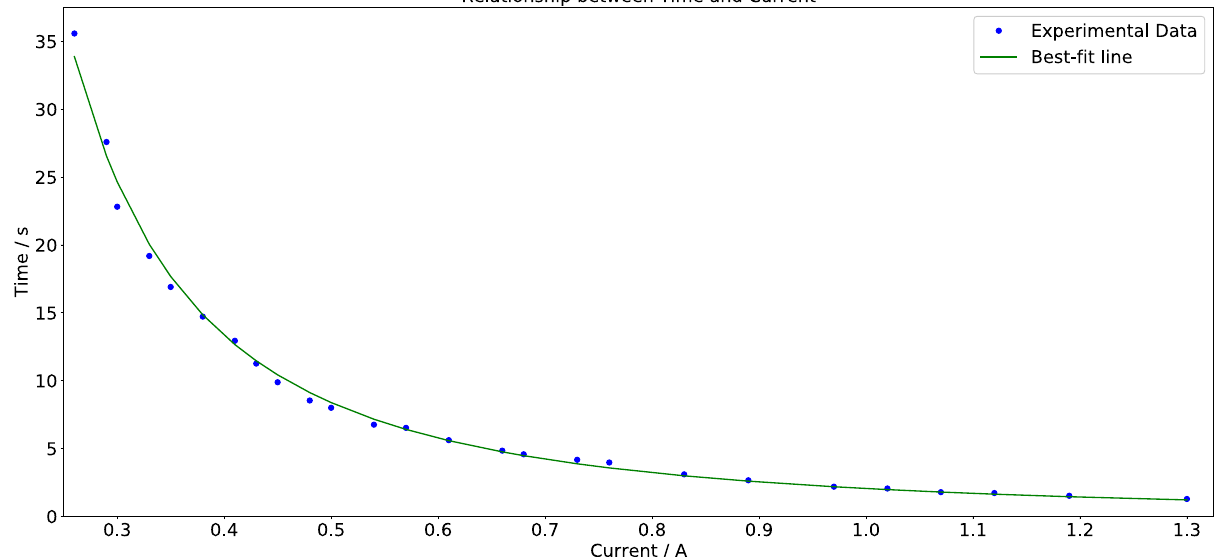
Fig. 4. Relationship between the current I and time taken to unwind t . The blue dots represent the experimental data values, whereas the green curve represents the best-fit curve with ∆ T = 18 . 23 ◦